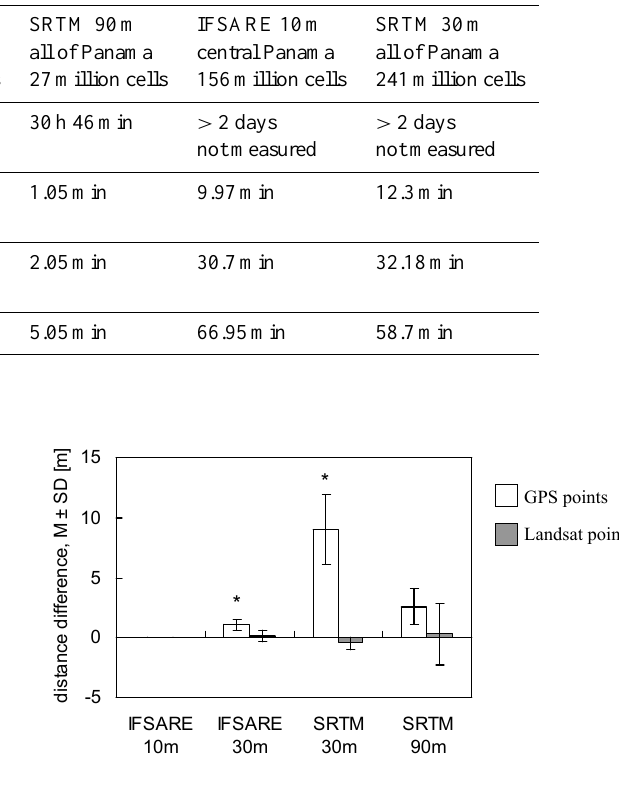
Fig. 6. Mean and standard deviation of the distance differences between impact reduction approach and least-cost path. A posi- tive distance difference indicates that streams extracted with least- cost path search are closer to reference points than streams extracted with the impact reduction